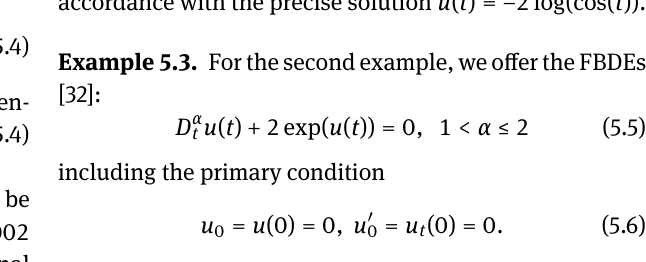
0.002, respectively, with Caputo and Caputo-Fabrizio frac- tional